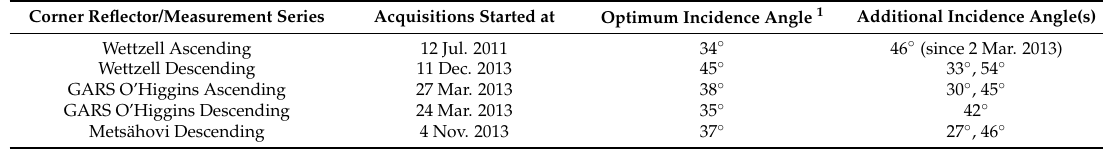
Figure 2. Corner reflectors at our test sites: ( a ) Wettzell, Germany; ( b ) GARS O’Higgins, Antarctic Peninsula; ( c ) Metsähovi, Finland. Table 1. Key figures of our SAR measurement series at geodetic observatories. Each CR is seen from two or three adjacent orbits though the CR is optimally oriented for only one of them (see column “optimum incidence angle”).